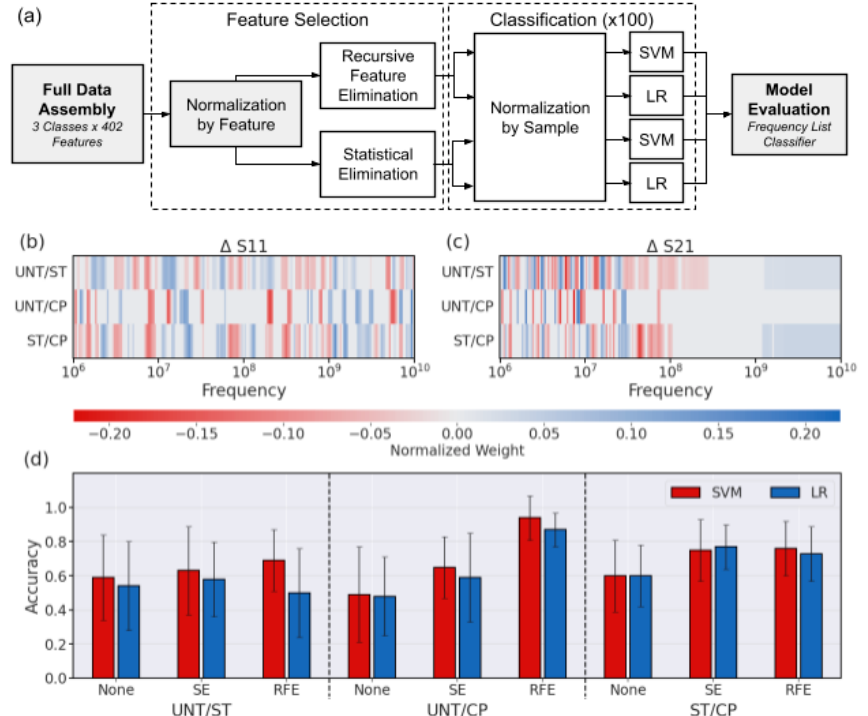
Figure 4. Approach and evaluation of cross-validated pairwise binary classifiers. ( a ) Schematic describing binary classification paradigm structure. ( b ) ∆ S11 and ( c ) ∆ S21 feature weights based on RFE + SVM classification for each pair. ( d ) Accuracy for predictions using each feature selection method and classifier for all binary pairs. The error bar indicates the standard deviation across the runs of cross-validation.